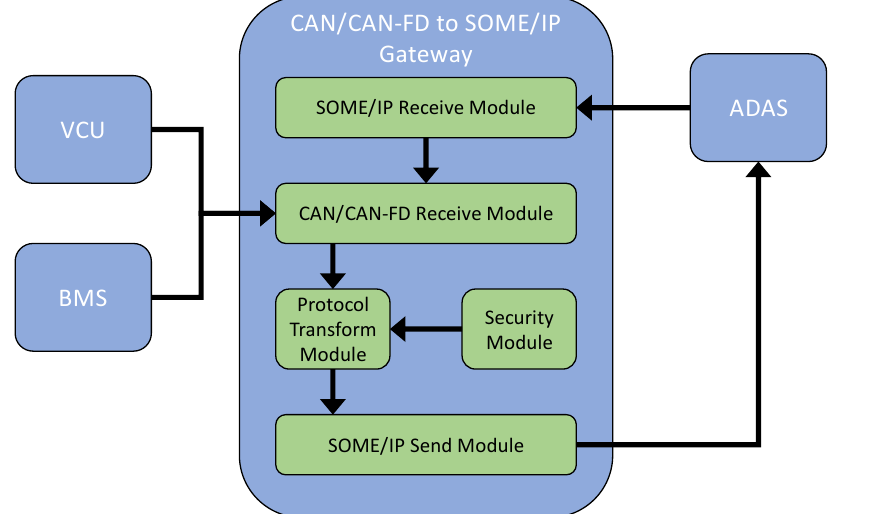
Sensors 2021 , 21 , 7917 Figure 7. Structure of a CAN/CANFD to SOME/IP gateway system. Figure 7. Structure of a CAN/CANFD to SOME/IP gateway system.